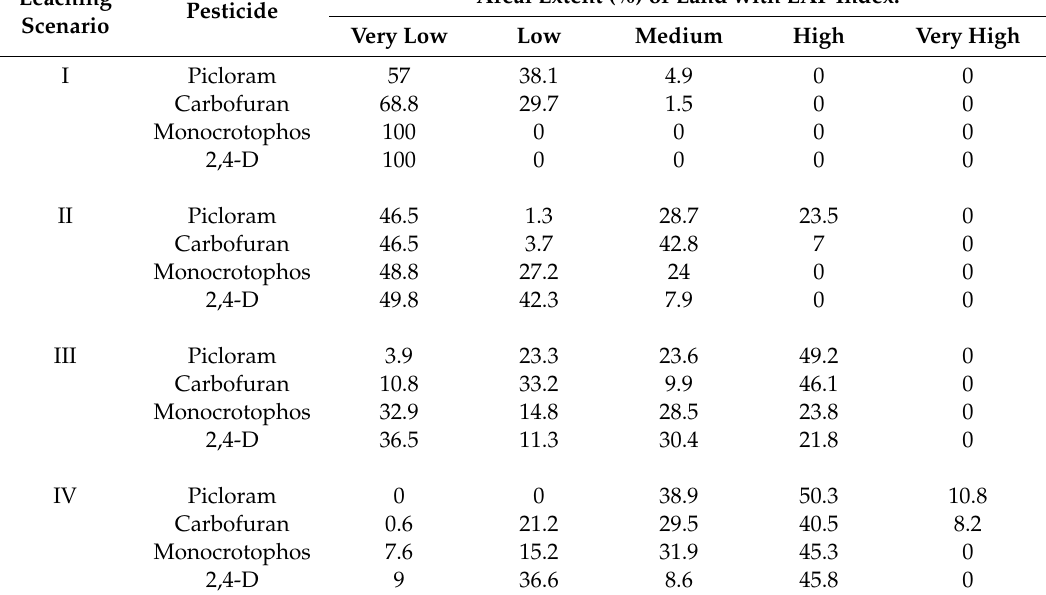
Areal extent (%) of leaching potential as indicated by the EAF index values for Picloram, Carbofuran, Monocrotophos, and 2,4-D pesticides under the di ff erent leaching scenarios in Jazan